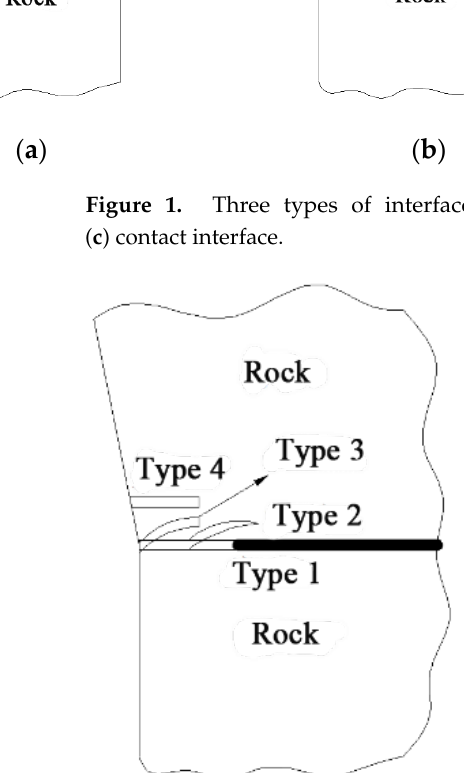
Figure 2. Four types of interfacial fracture.